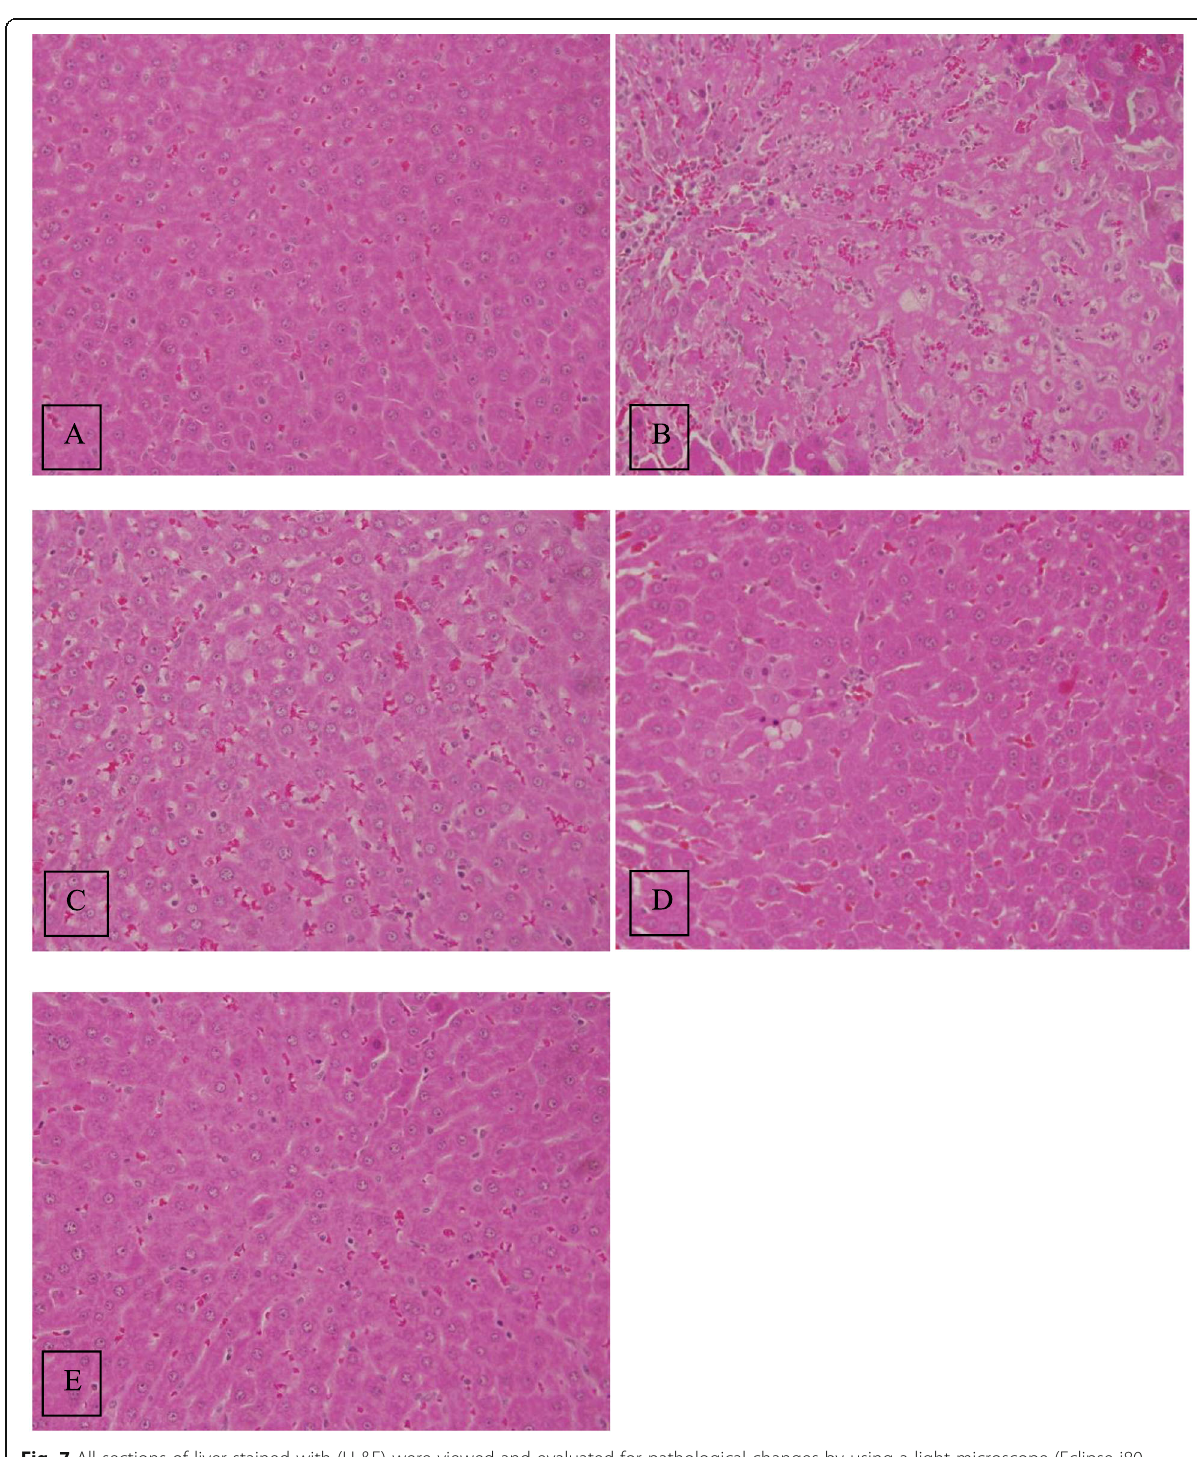
Fig. 7 All sections of liver stained with (H &E) were viewed and evaluated for pathological changes by using a light microscope (Eclipse i80, Nikon, Japan). The required images were taken with Nikon mounted digital camera (OXM 1200C, Nikon, Japan (400X). a - Normal Control b - Received APAP 1000 mg/kg c - DPP (50 mg/kg) + APAP d - DPP (100 mg/kg) + APAP e - Silymarin +